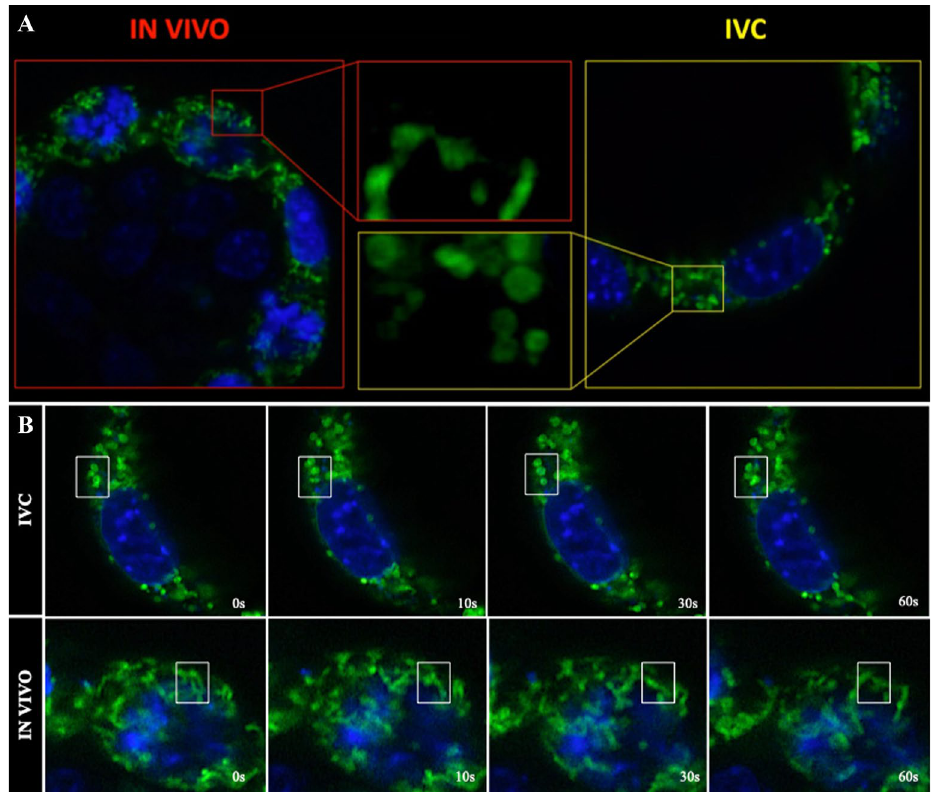
Figure 4. Mitochondrial dynamics and motility. ( A ) Shape of the mitochondria of the IN VIVO (left) and in vitro (right) blastocysts. Central pictures shown an enlarged of the yellow and red squares; ( B ) Images collected during the time lapse registation of IVC and IN VIVO blastocysts. Consucutive frames taken over 20 s show an enlargen section of live cells over time; white frames show examples of localized motion in the INC and IN VIVO blastocyst cell.